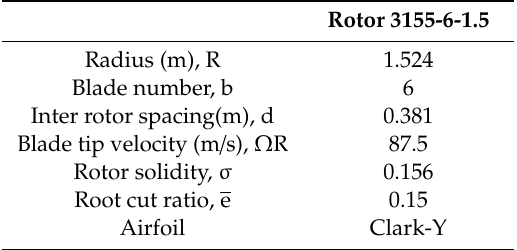
Table 2. Major parameters of coaxial-rotor 3155-6-1.5.